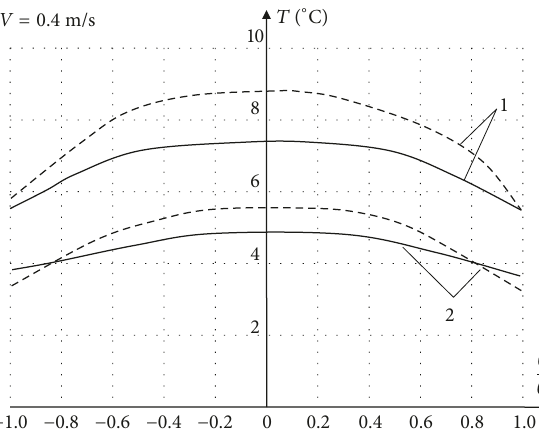
Figure 5: Temperature change in the hub for one stroke of the plunger for velocity of plunger motion 𝑉 = 0.4 m/s.